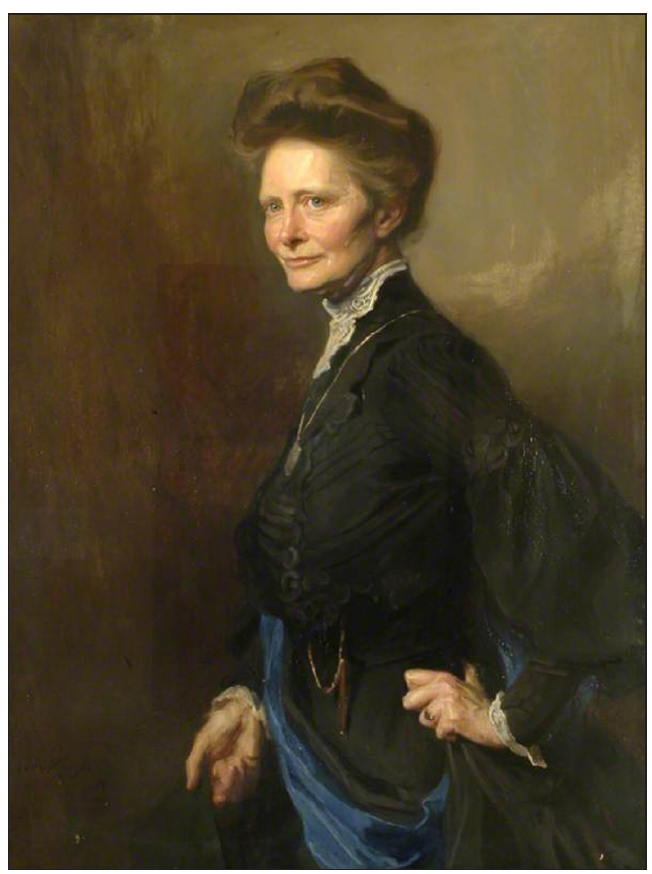
Fig. 7 : Philip Alexius de László, Dame Emily Penrose (1858–1942) , 1907, oil on canvas, 116.8 × 91.5 cm, Royal Holloway, University of London,